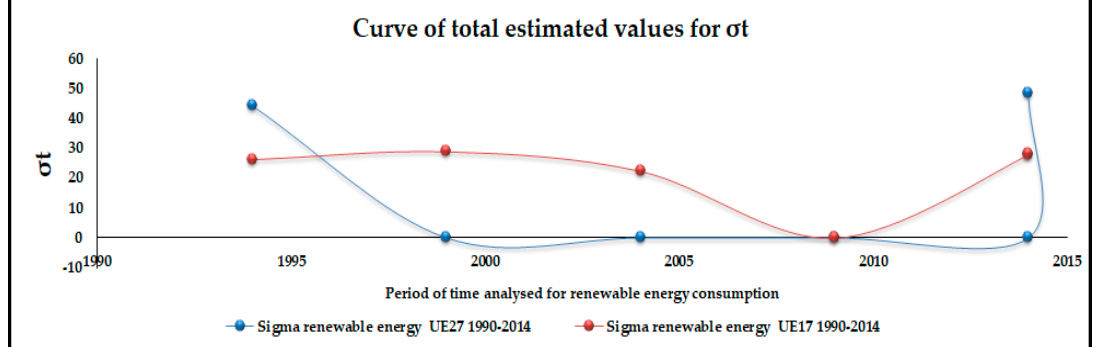
Figure 7. Graphical representation of total values obtained for σ t for renewable energy consumption.